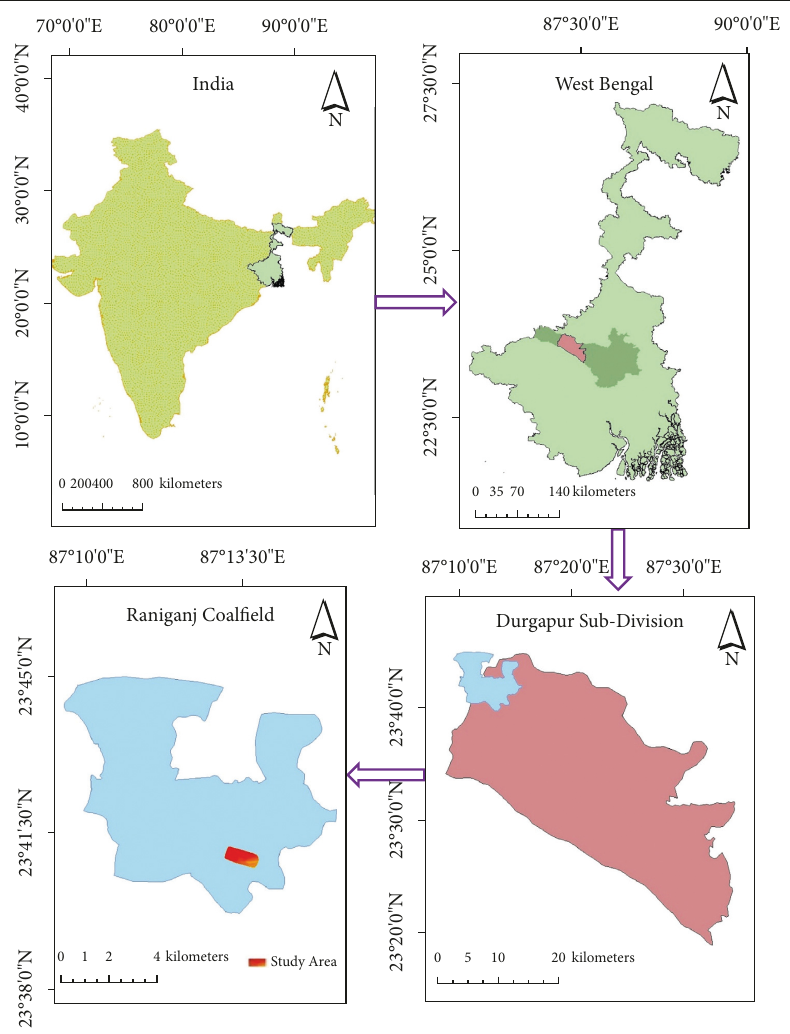
Figure 1: Map showing the study area, located in India’s eastern part.